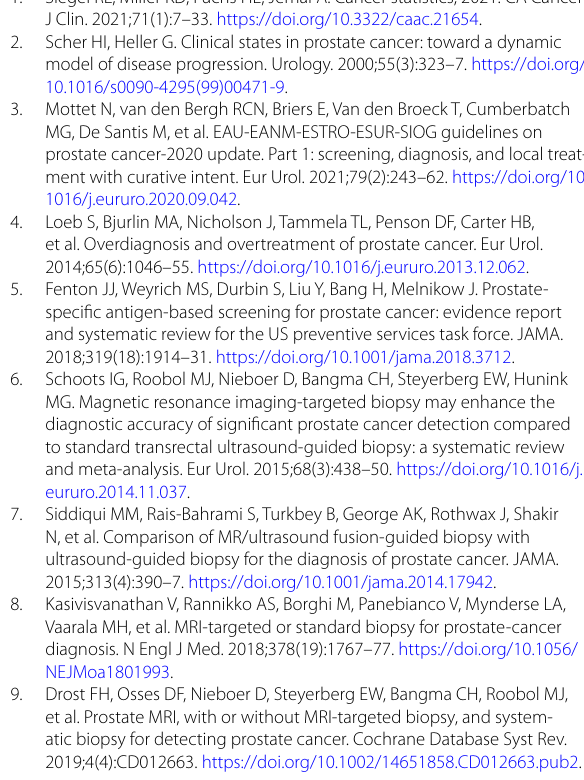
zone. Supplemental table 3. PI-RADS assessment of transition zone. Sup‑ plemental table 4. Diagnostic result of SUVmax for 68 Ga-PSMA PET/CT to discriminate positive or negative of prostate cancer. Supplemental fig. 1. ROC analysis of SUVmax for 68 Ga-PSMA PET/CT to discriminate positive or negative of prostate